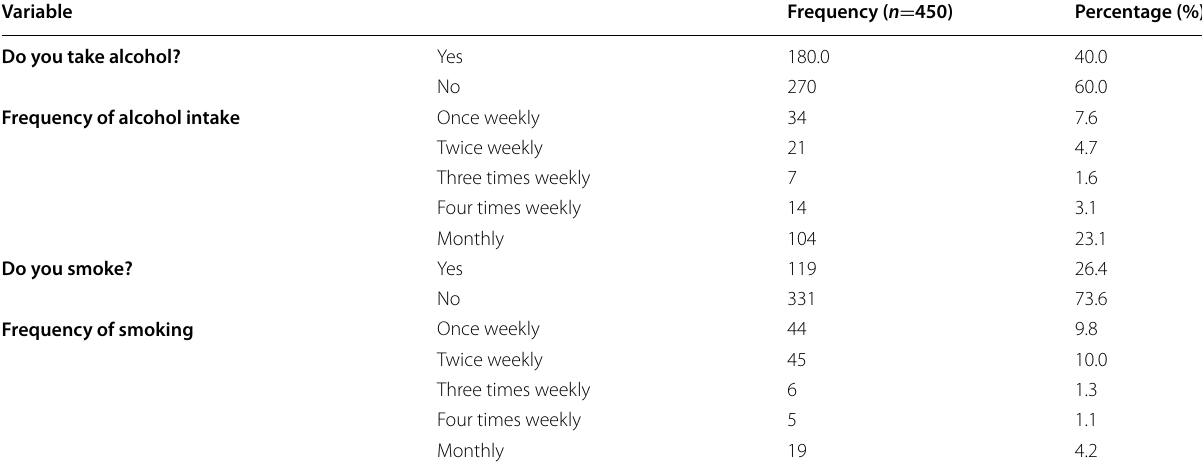
Table 3 Health behaviour of the participants Variable